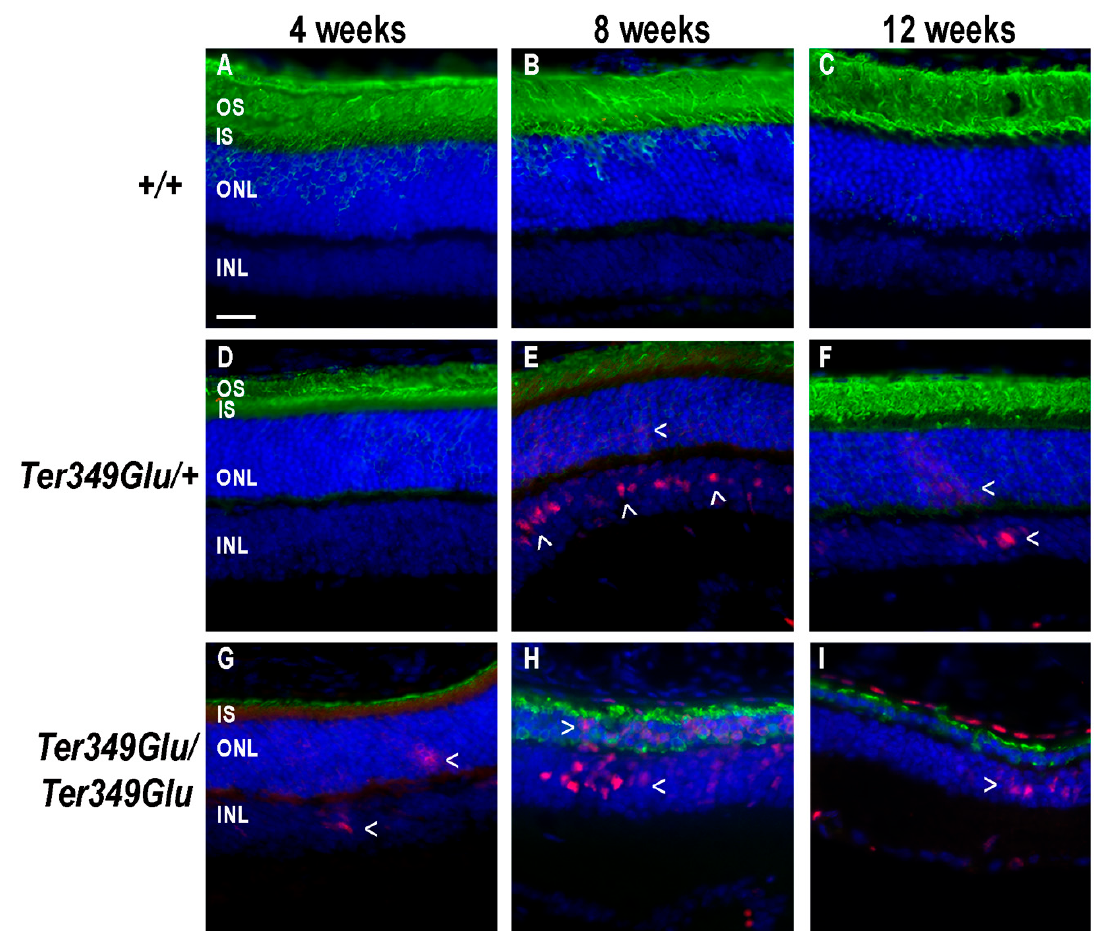
Figure 4. JAK/STAT pathway is activated in Ter349Glu rhodopsin knock-in mouse retina. Activation of the JAK/STAT pathway was examined using fluorescent immunohistochemistry on retinas from WT ( +/+, A – C ), Ter349Glu heterozygous ( Ter349Glu/+ , D – F ), and Ter349Glu homozygous ( Ter349Glu/Ter349Glu , G – H ) mice. Retinal sections were treated for antigen retrieval and labeled for phosphorylated STAT3 (pSTAT3, red) and rhodopsin (green). Nuclei were labeled with DAPI (blue). Arrowheads (>), areas of JAK/STAT activation; OS, outer segments; IS, inner segments; INL, inner nuclear layer. Scale bar = 20 μ m.